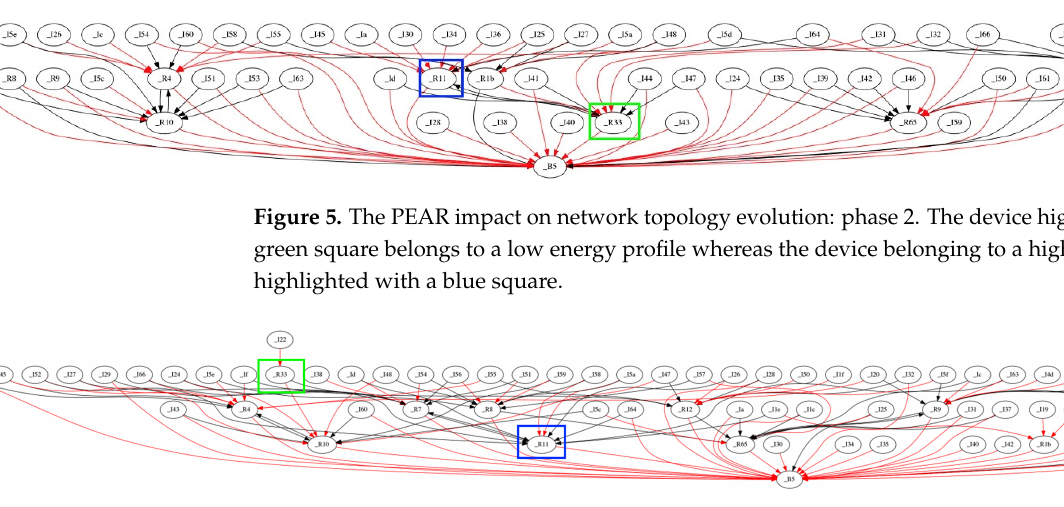
Figure 4. The PEAR impact on network topology formation: phase 1. The device highlighted with the green square belongs to a low energy profile whereas the device belonging to a high energy profile is highlighted with a blue square.